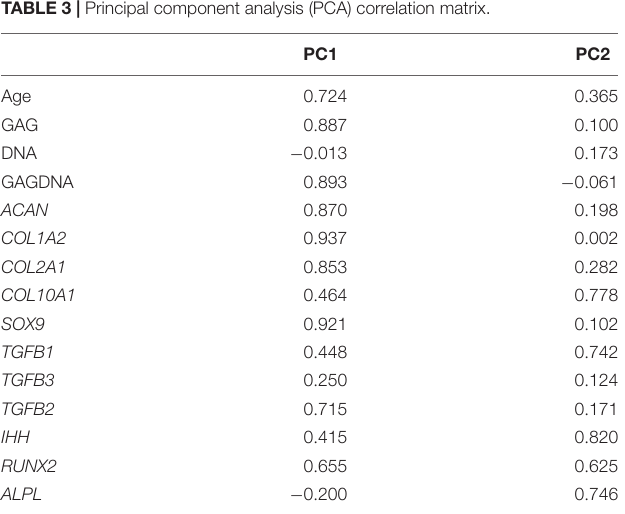
TABLE 3 | Principal component analysis (PCA) correlation